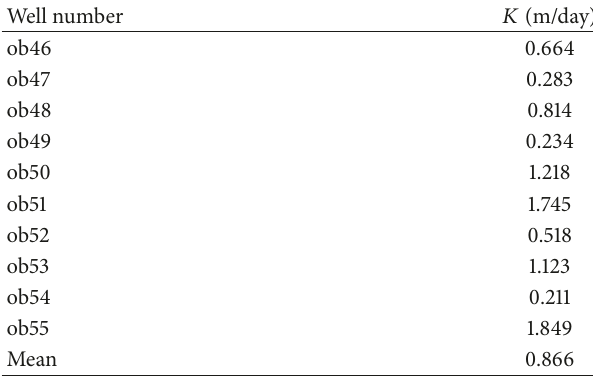
Table 1: Slug test results of the 10 observation